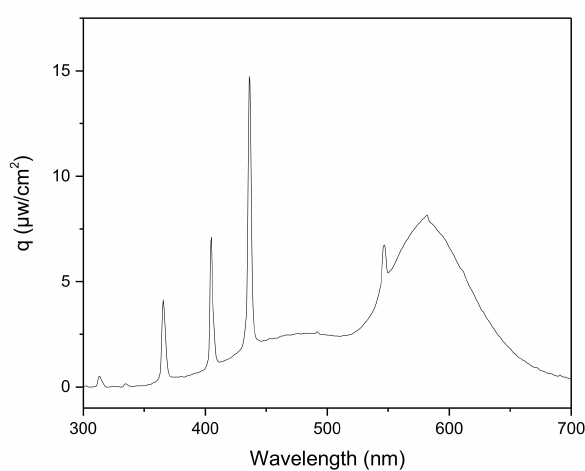
Figure A2. Near-UV Lamp Irradiation Spectrum.